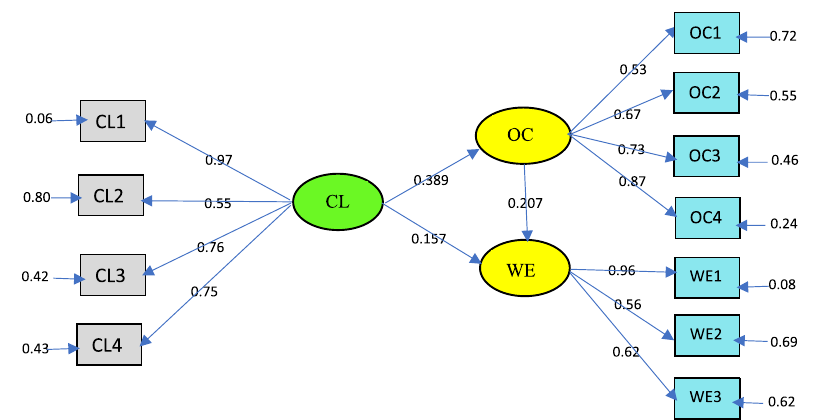
Fig. 2 The test results of the direct in fl uence of CL on OC and WE.